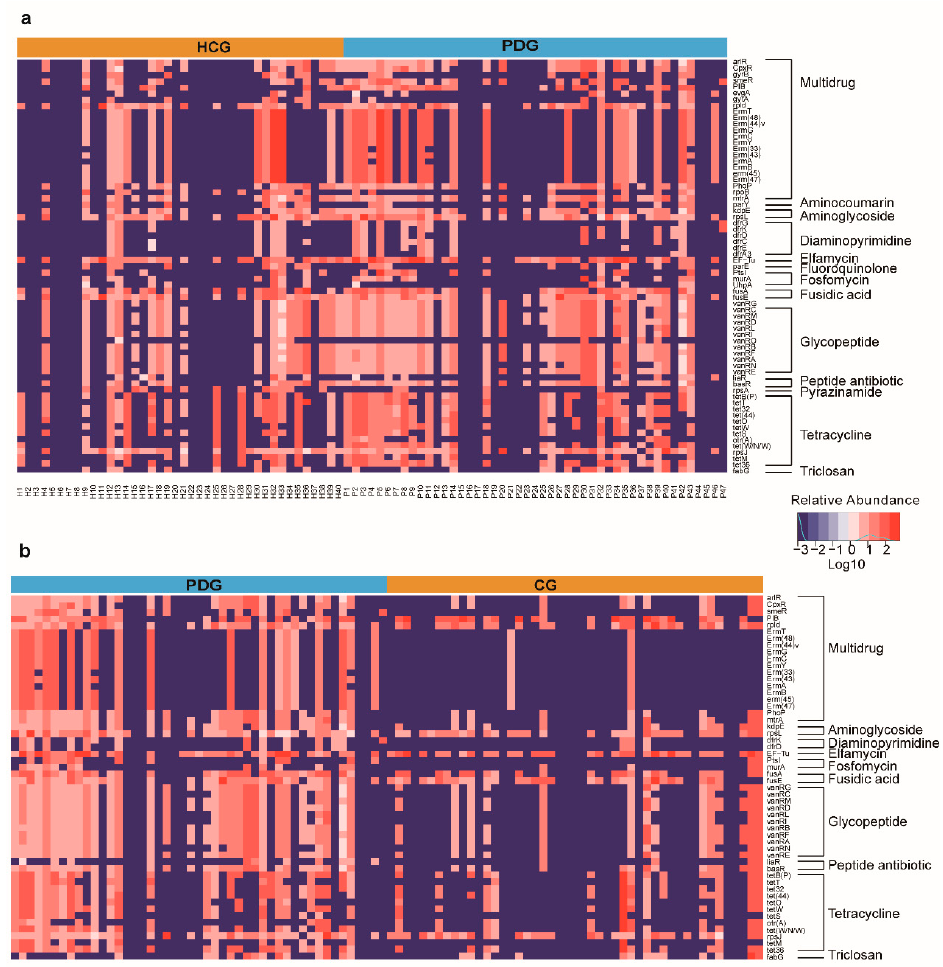
Figure 6. Alterations in antibiotic resistance genes among HCG, PDG, and CG. ( a ) Heatmap for the expressions of microbial antibiotic resistance genes between HCG and PDG. ( b ) Heatmap for the expressions of microbial antibiotic resistance genes between PDG and CG. The relative abundance changes from low to high are indicated by color changes from blue to red. The log10 value was used to show the abundance of antibiotic resistance gene. HCG: healthy control group. PDG: period of disease group. CG: convalescent group.